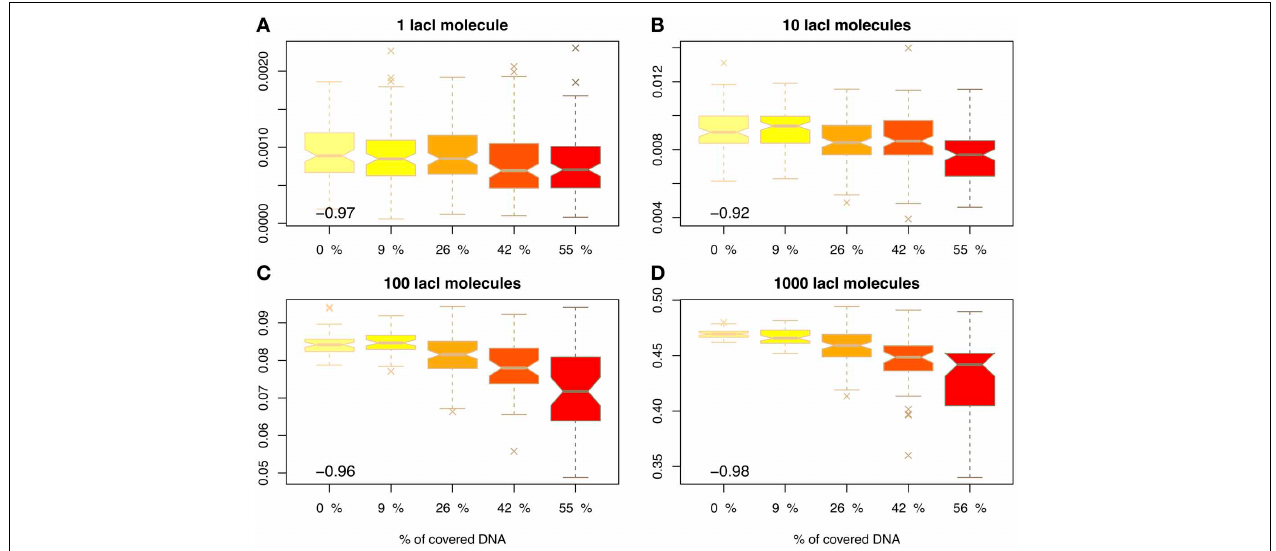
FIGURE 3 | Proportion of time relative to the cell cycle that the target site is occupied (y-axis) as a function of DNA crowding (x-axis) in the case of mobile obstacles. The number in the inset represents the Pearson coefficient of correlation between crowding and the mean of the proportion of time the O 1 site is occupied. The values indicate that crowding is highly anti-correlated with the proportion of time the target site is occupied, in the